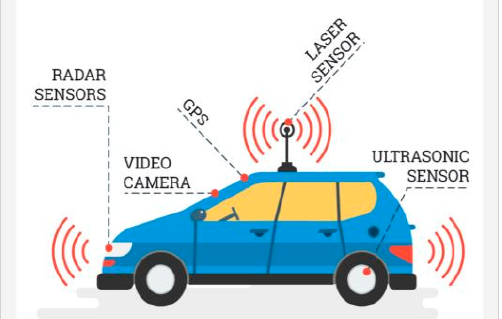
Figure 5. data fusion and machine learning are hugely important for detecting and identifyingboth Figure 5. Multi-sensor data fusion and machine learning are hugely important for detecting and static and dynamic targets. Excerpted from reference identifyingboth static and dynamic targets. Excerpted from reference [45].